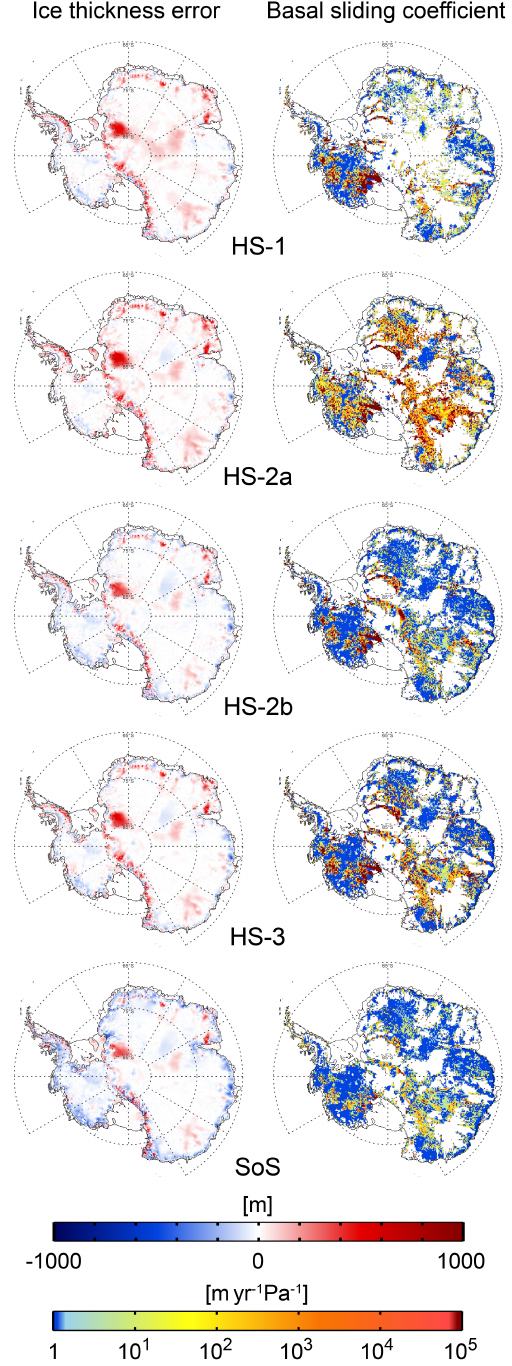
Figure 4. Left column: equilibrium surface velocities across the grounded ice areas derived from different schemes, in myr − 1 , com- pared to the observational data set from Rignot et al. (2011) (bot- tom), regridded to the model resolution of 20km. Right column: ratios of the modelled to observed surface velocities, plotted on a logarithmic scale. Velocities smaller than 2myr − 1 are excluded. Colour-code saturates at ratios larger than 100 or smaller than